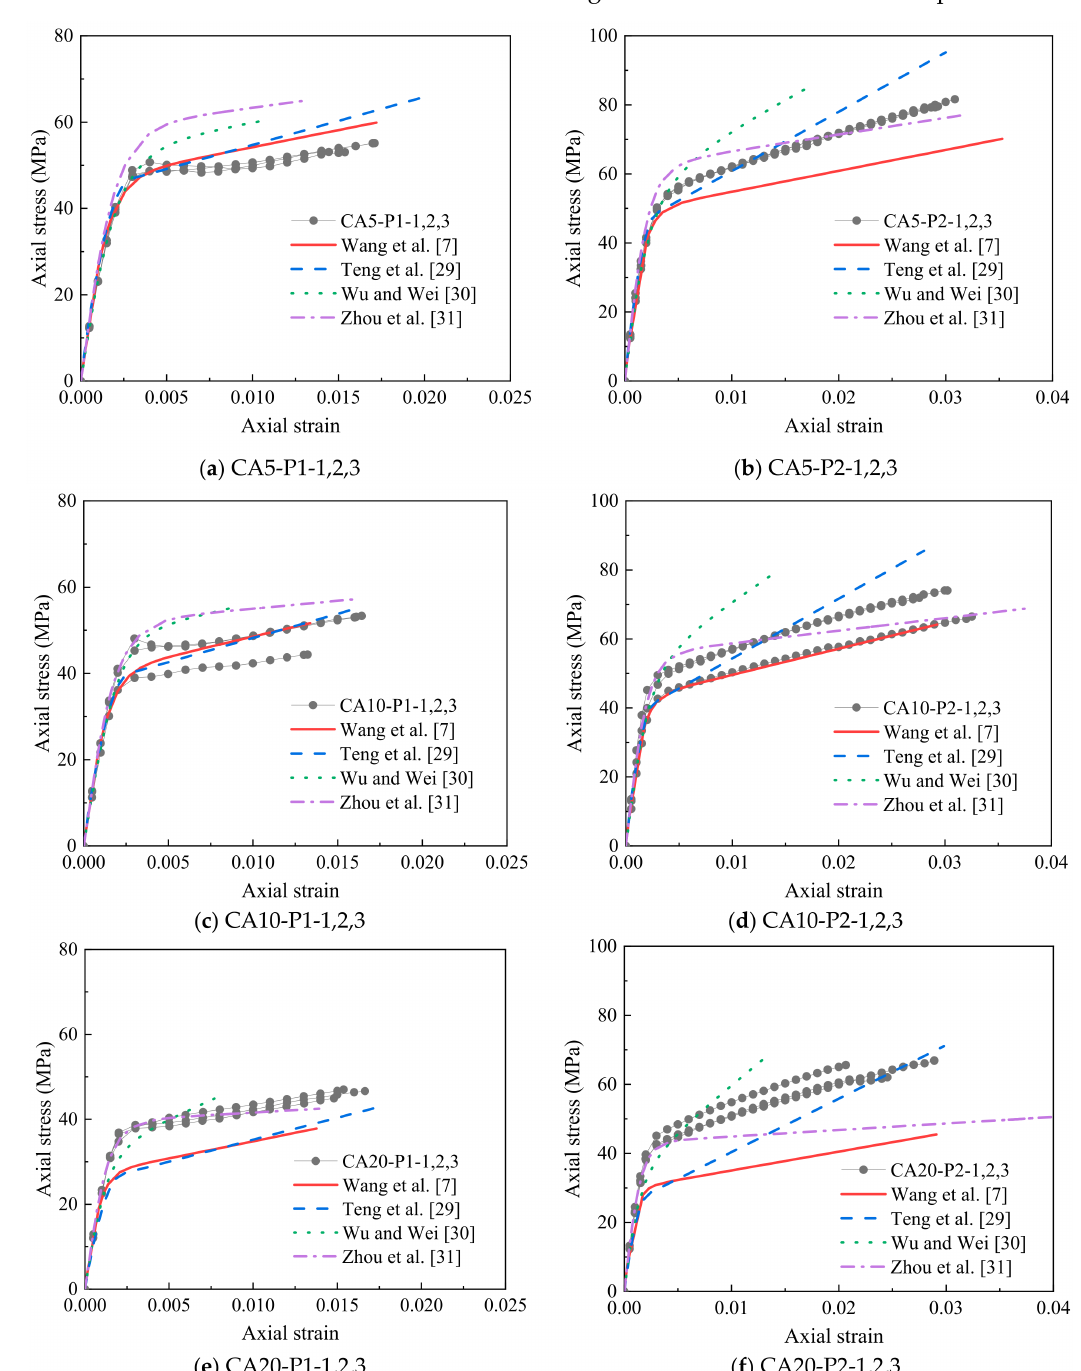
Figure 11. Comparison of the stress–strain